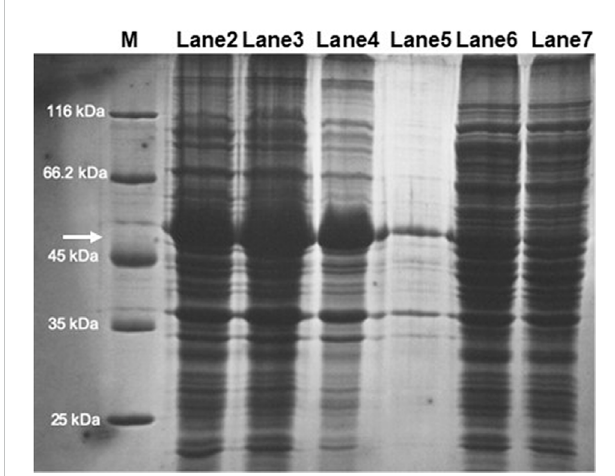
FIGURE 7 SDS-PAGEanalysis ofC4ST-1overexpressionintransformed E.coli BL21 (DE3) cells: M, molecular weight marker; Lanes 2 – 4: insoluble protein fraction (IPF); Lanes 5 – 7: soluble protein fraction (SPF). The arrow points to the protein whose size matches that of C4ST-1.